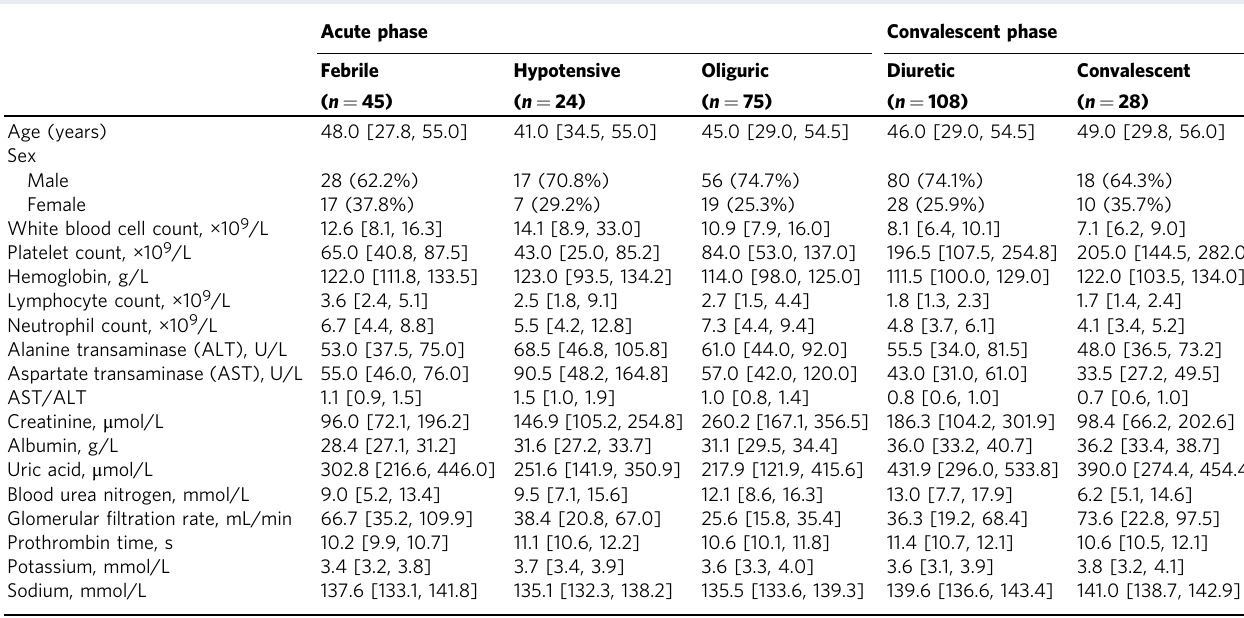
According to clinical practice, the acute phase should cover febrile, hypotensive, and oliguric stages and the convalescent phase diuretic and convalescent stages. Data are presented as the median (interquartile range, IQR) or n (%). HFRS hemorrhagic fever with renal Supplementary Fig. 2, the patient samples were counted according to the stages of the disease; febrile, hypotensive, oliguric, diuretic, and convalescent. As the disease progressed, the number of the HTNV + CD8 + cells gradually decreased. In contrast, the proportion of HTNV-infected CD4 + T cells between acute and convalescent phases has no statistical differences ( P = 0.159). Taken together, these data indicate that HTNV speci fi cally infects CD8 + T cells. To provide more supporting information, we then sorted NP + and NP - CD8 + T cells prepared from freshly isolated PBMC from patient H20-2, and measured viral mRNA expression in the two populations using qRT-PCR and found that the viral load of NP-positive CD8 + T cells was much higher than that of NP-negative cells (Supplementary Fig. 3).